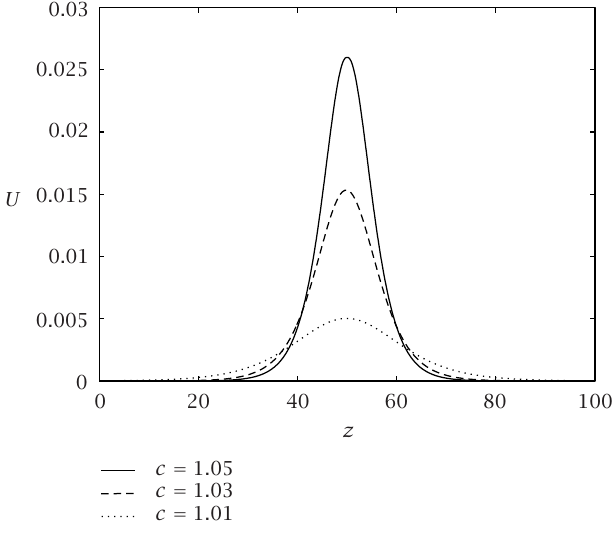
Figure 3.1. Solitary waves of the SGBE by numerical integration.